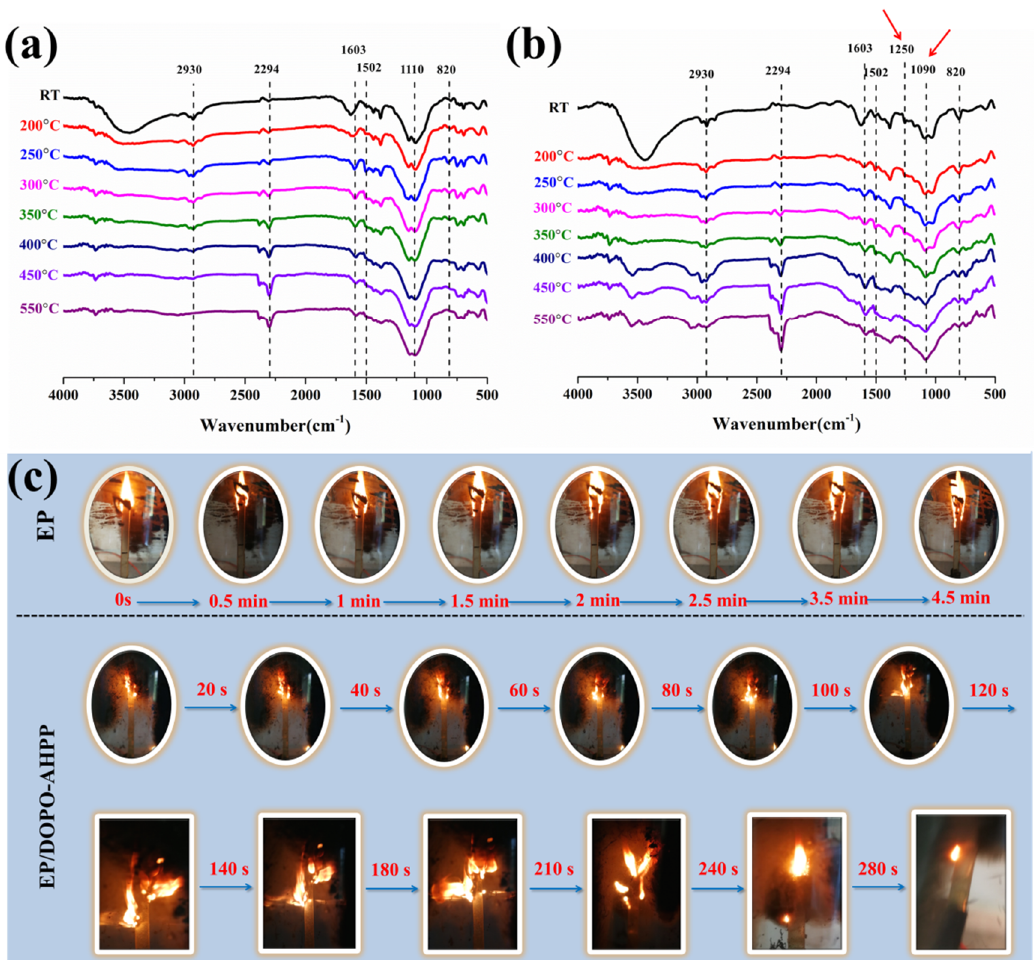
Figure 3. FTIR spectra of pristine EP ( a ), EP/DOPO-AHPP ( b ) at different pyrolysis temperatures, and video screenshots of pristine EP, EP/DOPO-AHPP at oxygen concentrations of 23.5% and 32% during LOI test ( c ).